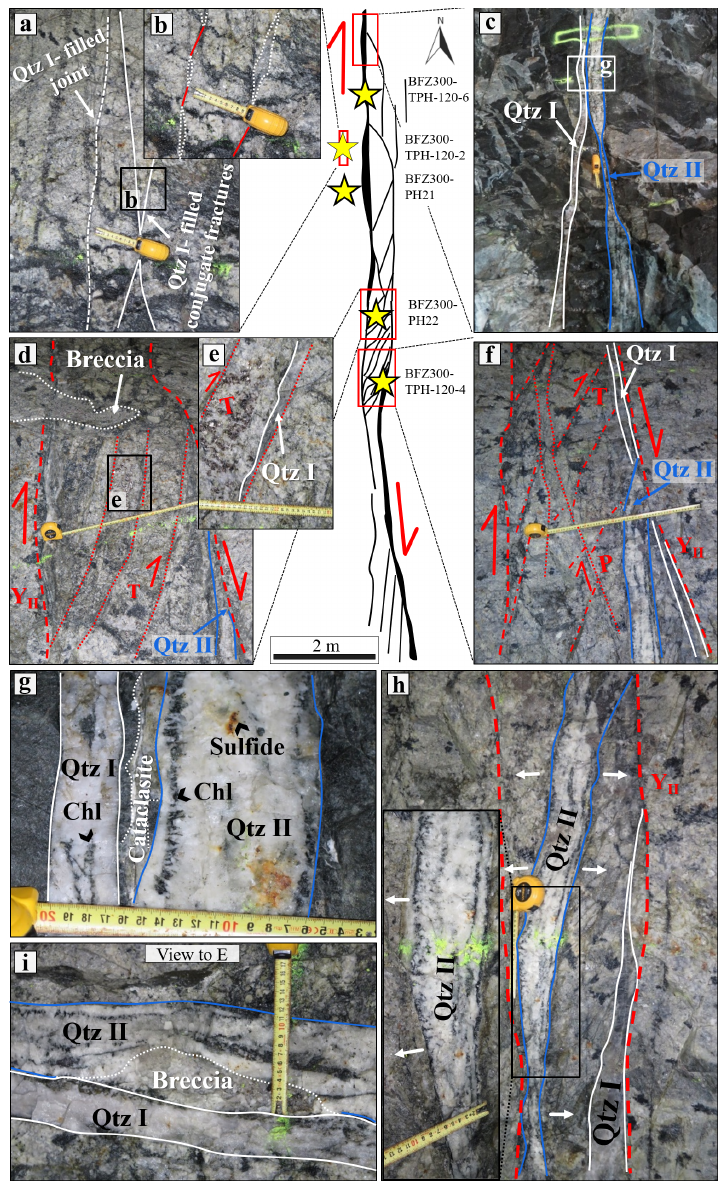
Figure 3. BFZ300 architecture with examples of representative structural features. The red rectangles locate the areas where detailed outcrop photos were taken. Stars locate hand and drill core samples. Stars with a black outline identify samples used for the microthermometric study. Note that the fault is made of two main segments offset laterally at a sinistral compressive step-over zone. Fault core quartz veins are shown by thicker black lines in the schematic model (centre of figure), while blue and white lines highlight the positions of the two types of quartz veins in the outcrop pictures. (a) Damage zone made of millimetre-thick, en echelon veins connected by conjugate shear segments. (b) Detail of (a) showing fractures filled by the first quartz generation (Qtz I). (c) Two distinct generations of quartz–chlorite veins recognized in the fault core (Qtz I and Qtz II). (d) Detail of the sinistral compressional step-over zone characterized by multiple and parallel T fractures, filled by Qtz I. A brecciated body is cross-cut by the Y planes. (e) Tensional fracture infilled by Qtz I. (f) Compressional structures ( P shears) from the step-over zone and relationships between Qtz I and Qtz II. The Riedel geometry suggests that the Qtz II vein formed due to the reactivation of the internal principal slip zones ( Y II ). Note the Qtz II vein cutting the Qtz I vein. (g) Juxtaposed Qtz I and Qtz II veins. Qtz I veins are thinner and made of a translucent, small-grained quartz. In contrast, Qtz II veins, which contain pockets of sulfide aggregates, are thicker and made of larger and euhedral quartz. Chlorite occurs as a minor phase in both veins. Notice the presence of a cataclastic band between the two veins. (h) Spatial continuity of the chlorite aggregates within the Qtz II veins, which always grow orthogonal to the vein boundaries. This open-space filling texture suggests hybrid conditions of reactivation of the older Qtz I veins. (i) Small quartz breccia formed between the two generations of quartz